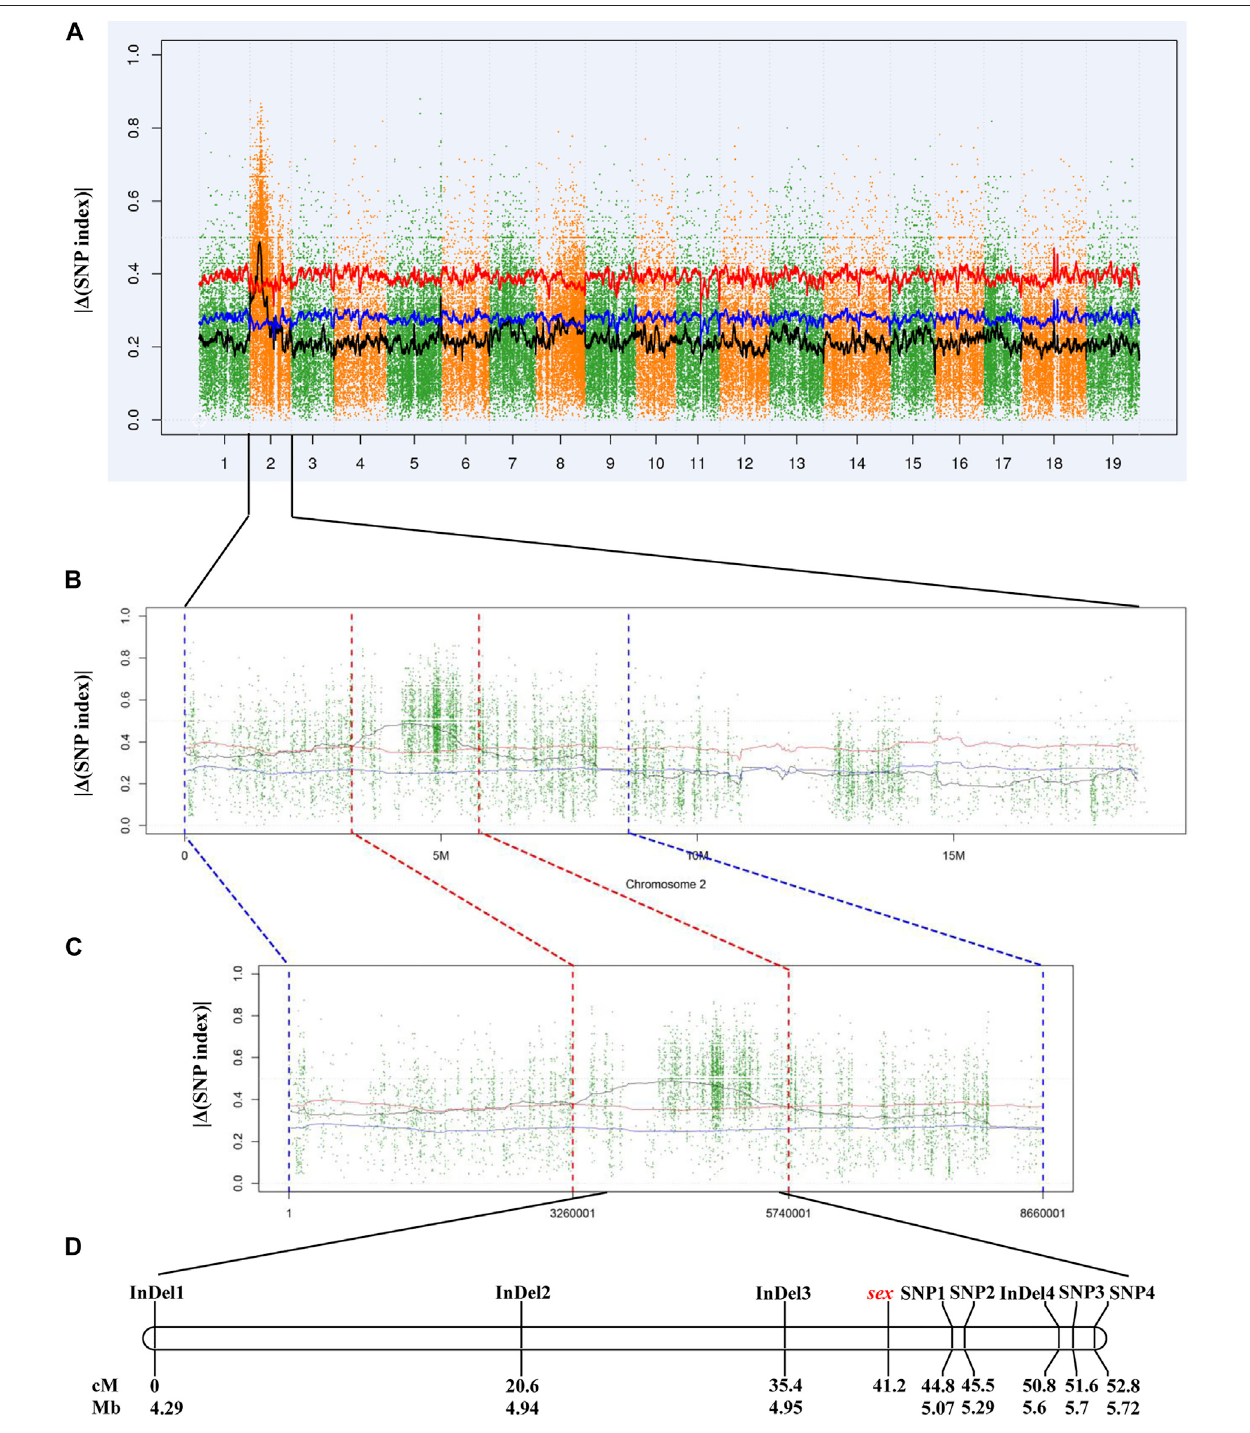
FIGURE2| MappingofsexlocusbyNGS-basedBSAandlinkageanalysis. (A) Genome-wide| Δ (SNPindex)|graph.( B) | Δ (SNPindex)|graphofchromosome2.( C) | Δ (SNPindex)| graphin thecandidate region.( D) Genetic and physicalmap oftheregion harboring sexlocus.Theblue and redlines indicatethe con fi dencelevelof0.05 and 0.01,